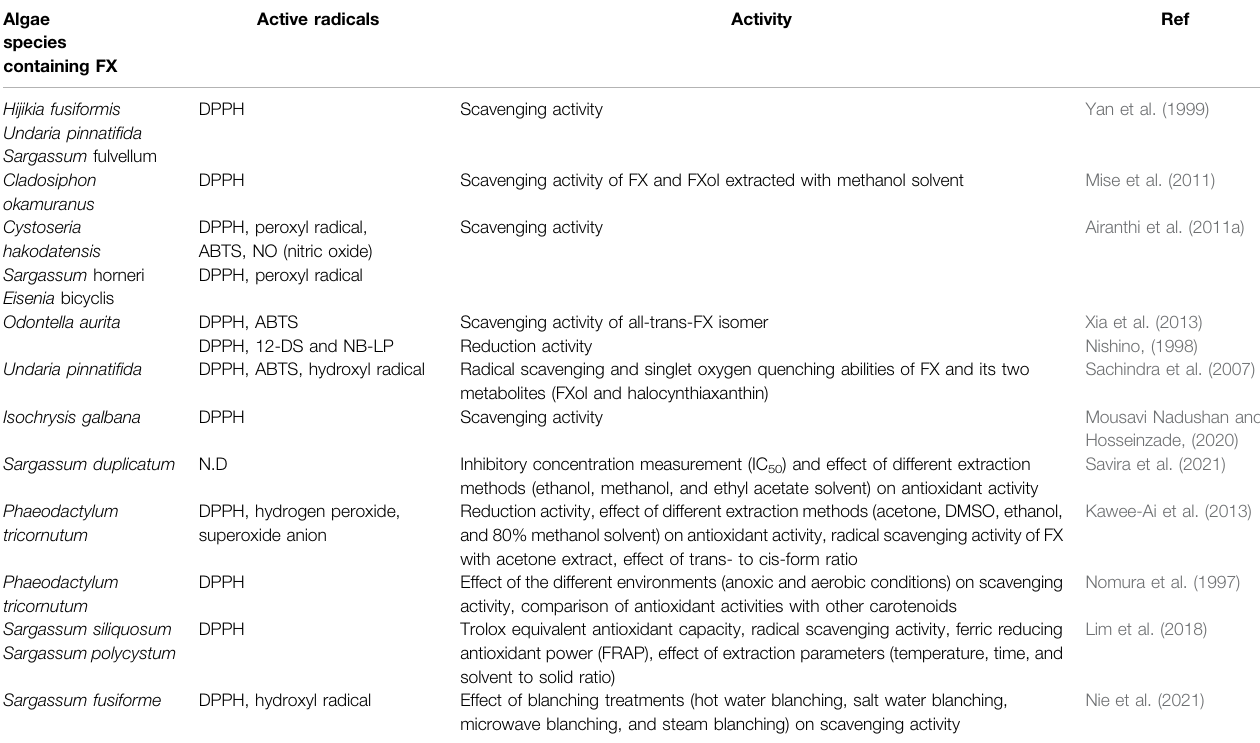
TABLE 3 | Antioxidant properties of FX extracted from various algae against free radicals. Algae